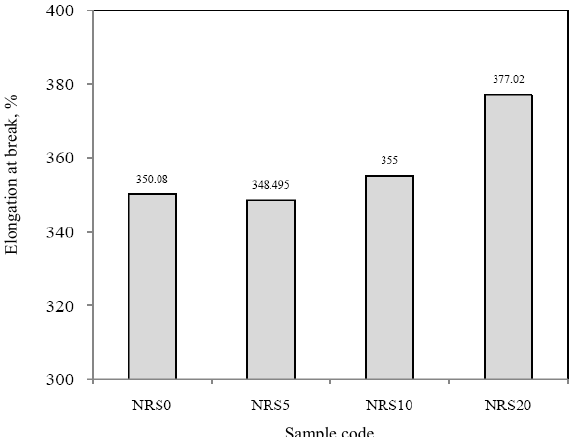
Figure 6. Elongation at break of samples at various silica ratios.